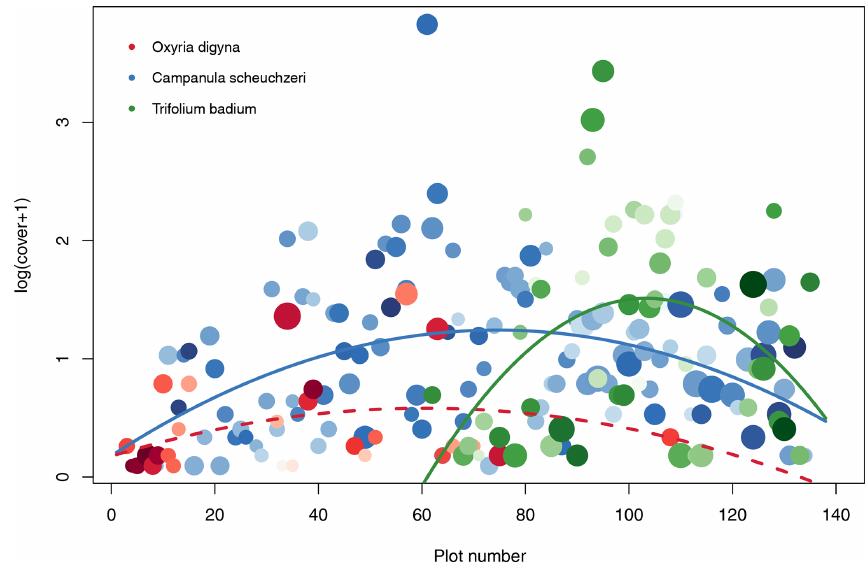
Figure 5. Distribution of the three intensively studied plant species Oxyria digyna (Polygonaceae; red), Trifolium badium (Fabaceae; green), and Campanula scheuchzeri (Campanulaceae; blue). The abundance of each plant species given as log(cover + 1) is given for the three plant species on each plot. Missing circles indicate that the species are absent from a given plot. Lines show significant quadratic regression models with plot number as an explanatory variable and cover as a dependent variable; the dashed line indicates a statistically nonsignificant association. The size of the circles is proportional to relative mean height of the species on each plot (plant height values are standardized for each species between 0 and 1); the darkness of the circles is proportional to mean leaf area, with light colors indicating relatively small leaves within a species and dark colors indicating larger